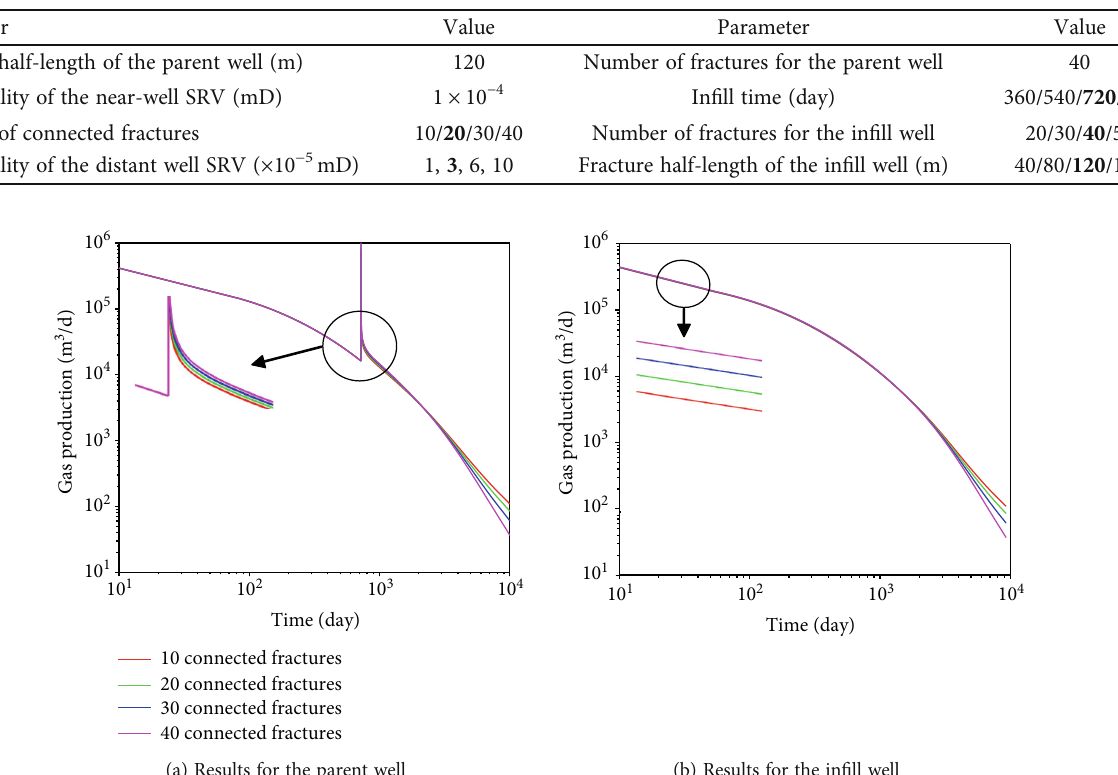
Figure 5: The gas production comparison results for the two-well interference case. Table 4: The analyzed parameters for the synthetic cases.